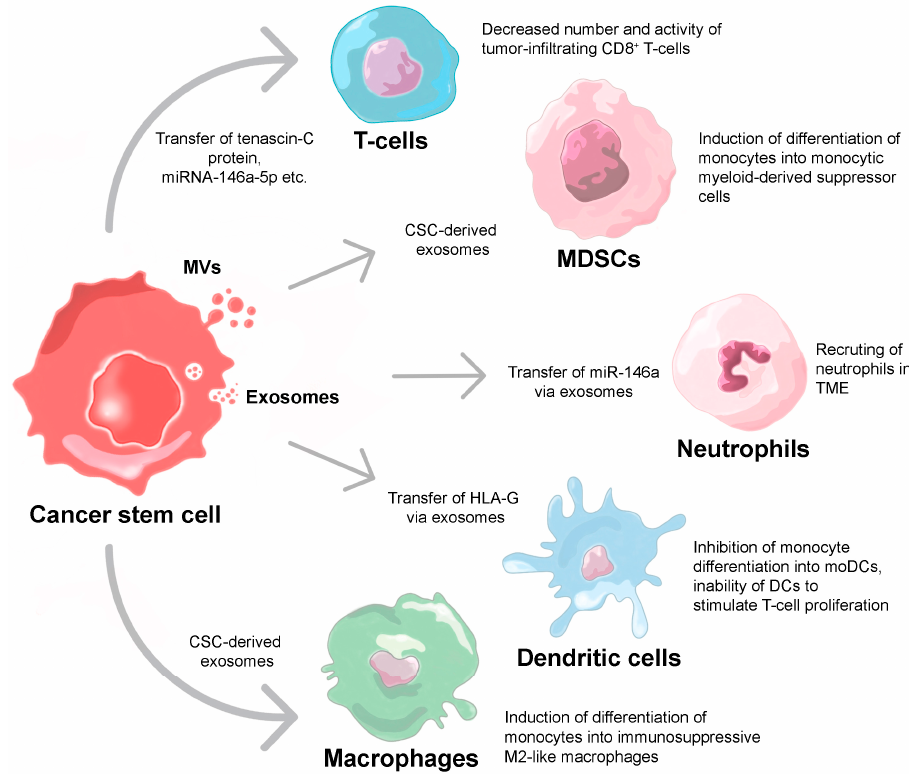
Figure 2. The influence of extracellular vesicle-transferred molecules on immune cells. Transfer of the specific proteins and mRNAs from parental CSCs via extracellular vesicles mediated suppression of cytotoxic T-cells and DCs as well as recruiting of tumor-supporting neutrophils, macrophages and MDSCs.